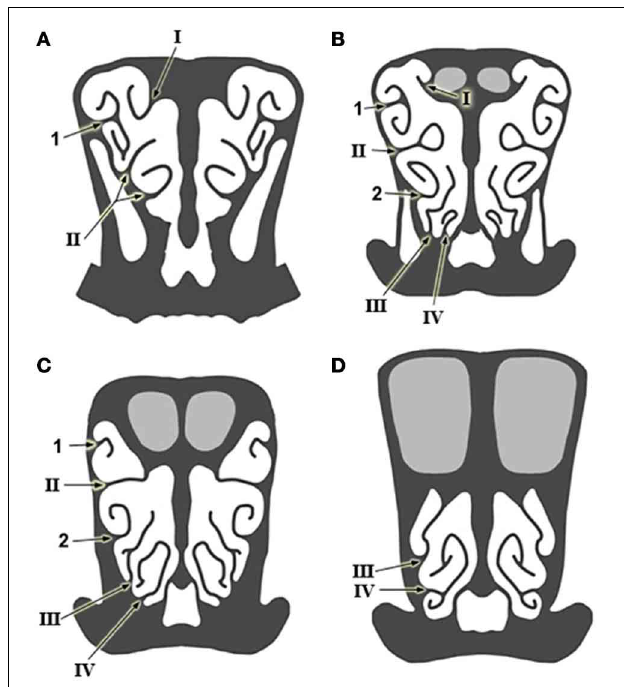
FIGURE 3 | Schematic drawings of transverse sections of the head, from anterior to posterior levels (A–D), showing the arrangement of the ethmoturbinates at several levels in the posterior part of the nasal cavity. Numbering as in Figure 1